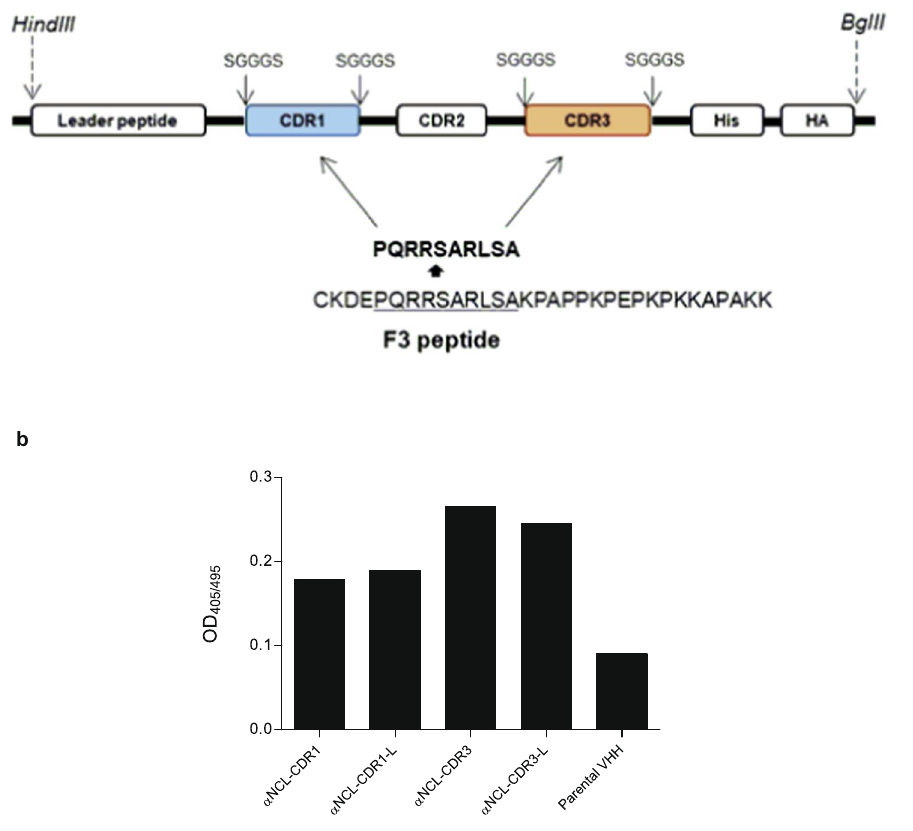
Figure 1. Development of different VHH constructs and binding to human nucleolin. ( a ) VHHs were developed by grafting a nucleolin-binding peptide sequence, either onto CDR1 or CDR3, with or without flanking linkers, at the end of the grafted CDR. ( b ) Binding of the generated VHHs, and the corresponding parental VHH, to human nucleolin, following 1 h incubation at 37 °C. Results are from a representative